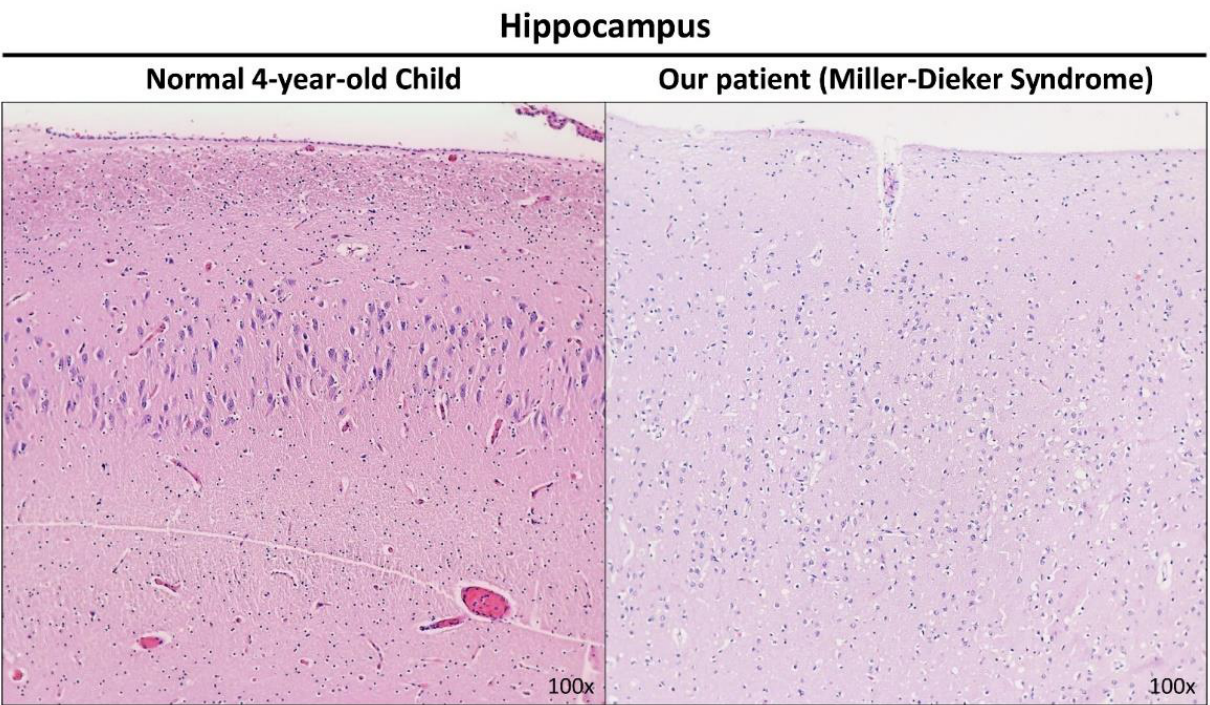
Figure 7. Microscopic image of the hippocampus. The hippocampus showed abnormally layered gray matter ( Right panel ) compared to a normal 4-year-old child’s hippocampus ( Left panel ) (H&E; 100x magnification).